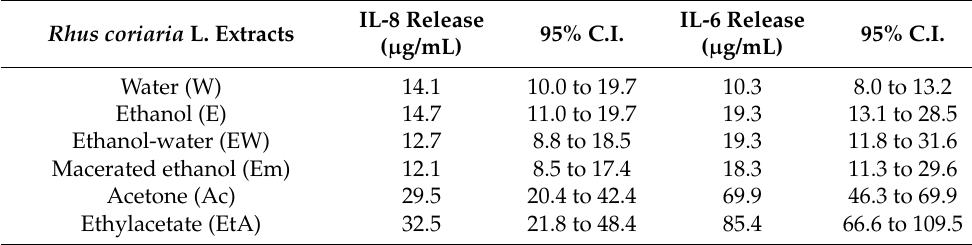
Table 2. Summary of IC 50 s ( μ g/mL) of Rhus coriaria L. extracts on IL-8 and IL-6 secretion induced by TNF- α in GES-1 cells.